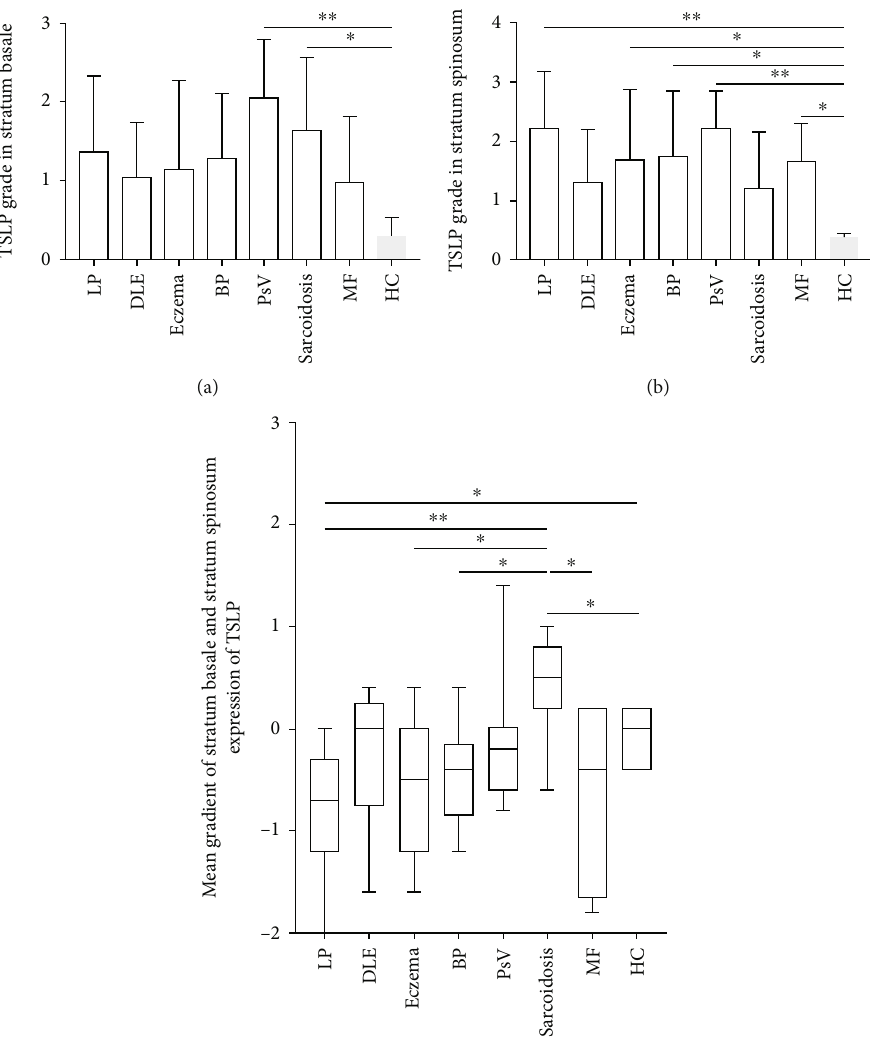
Figure 2: TSLP was signi fi cantly expressed in the epidermis in LP, BP, eczema, PsV, sarcoidosis, and MF and nonsigni fi cantly expressed in DLE, in a semiquantitative analysis. (a) TSLP was signi fi cantly expressed in the stratum basale of the epidermis with PsV and sarcoidosis specimens. (b) TSLP was signi fi cantly expressed in the stratum spinosum of LP, eczema, BP, PsV, and MF. (c) TSLP expression in the stratum basale was signi fi cantly higher than that in the stratum spinosum in sarcoidosis specimens and was signi fi cantly lower in the stratum spinosum in LP specimens, but not signi fi cant in other dermatoses. The mean gradient of stratum basale and stratum spinosum expression of TSLP in sarcoidosis was di ff erent from in LP, eczema, BP, and MF, respectively. The score of each section was graded semiqualitatively on a scale of 0 – 3 (0: negative, 1: mild, 2: moderate, and 3: strong) blindly by two dermatologists in fi ve randomly visual fi elds at high power fi eld (HPF, × 400 magni fi cation) of scanned sections. The gradient of the stratum basale and the stratum spinosum was mathematically calculated by subtracting the stratum basale score from stratum spinosum. p values were determined by the one- group Student t -test. Signi fi cant di ff erences are noted between the groups: n.s.: not signi fi cantly di ff erent; ∗ p < 0 : 05 ; ∗∗ p < 0 : 01